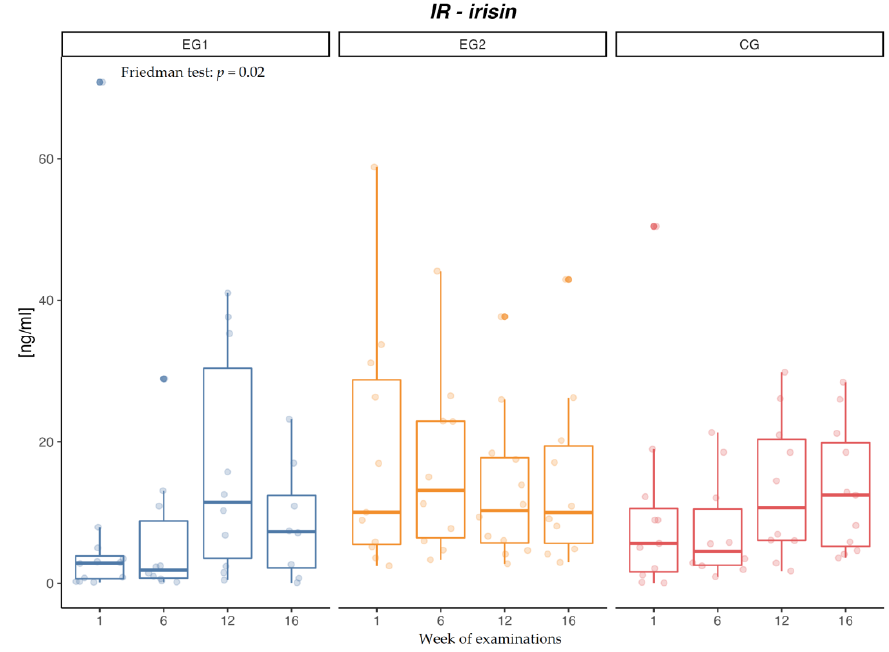
Figure 2. Changes in irisin (IR) concentration [ng/mL] in the aerobic group (EG1), aerobic-resistance group (EG2), and control group (CG) during weeks of examinations.